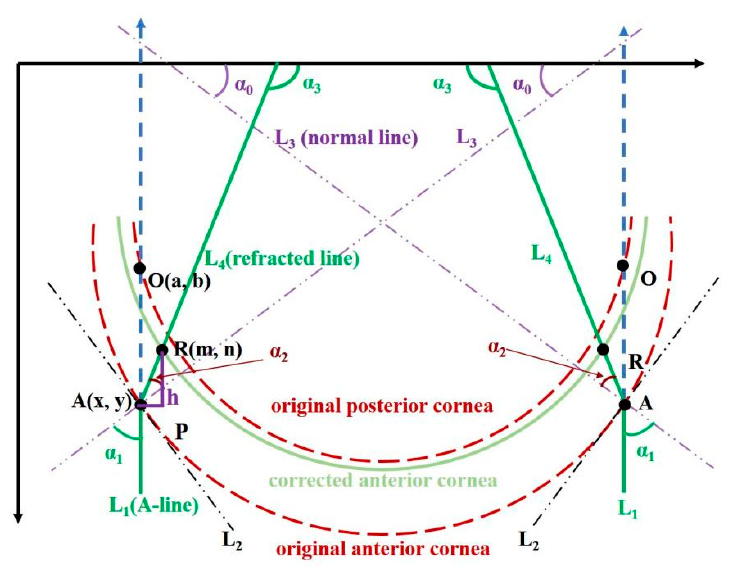
Figure 2. Schematic example of refractive-index correction of air–cornea interface.